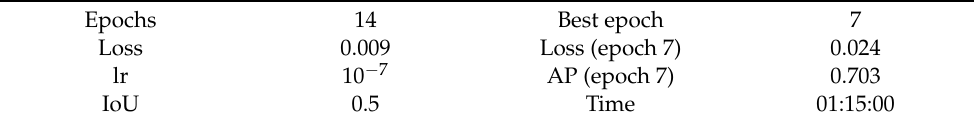
Table 4. Retraining parameters and